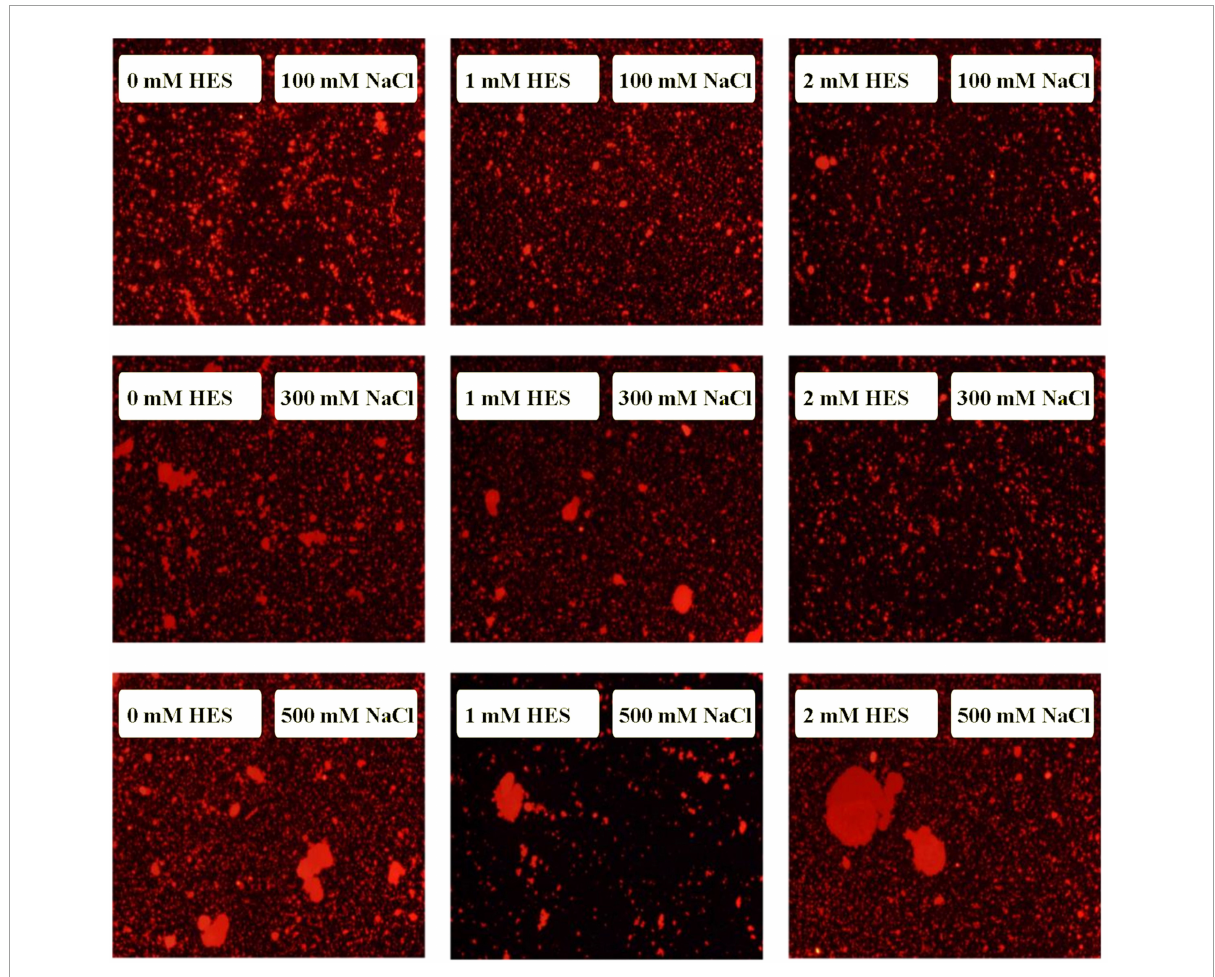
FIGURE10 The microstructure of emulsions with different salt ion concentrations under acidic condition.